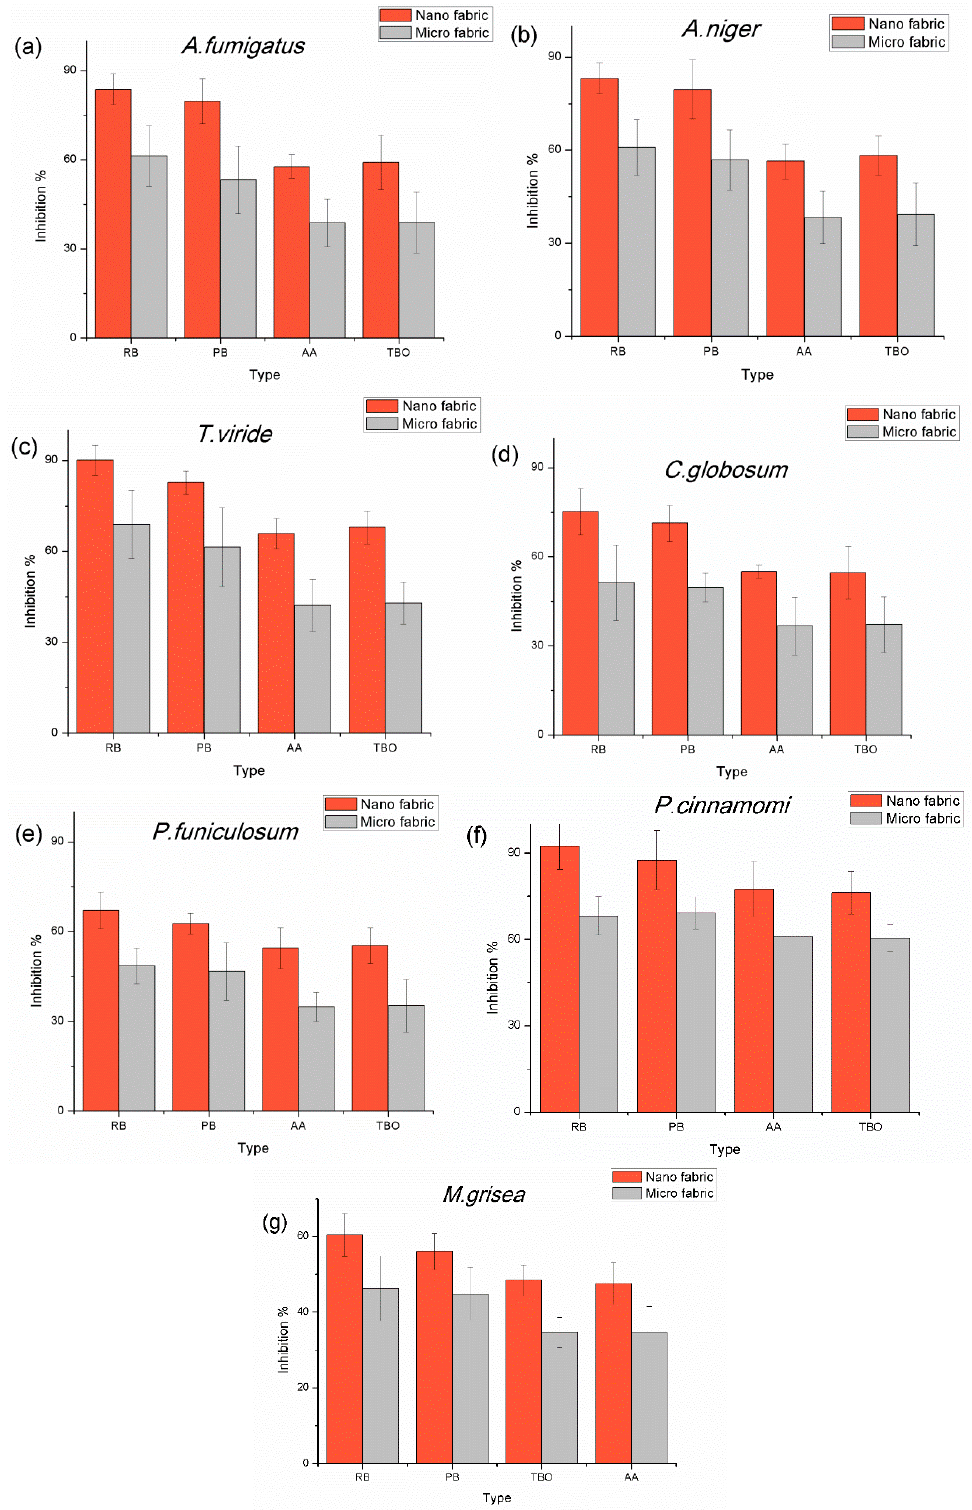
Figure 5. Inhibition percentages of the nano and micro fabrics with immobilized RB, PB, AA, and TBO photosensitizers on ( a ) A. fumigatus ; ( b ) A. niger ; ( c ) T. viride ; ( d ) C. globosum ; ( e ) P. funiculosum ; ( f ) P. cinnamomi ; and ( g ) M. grisea.